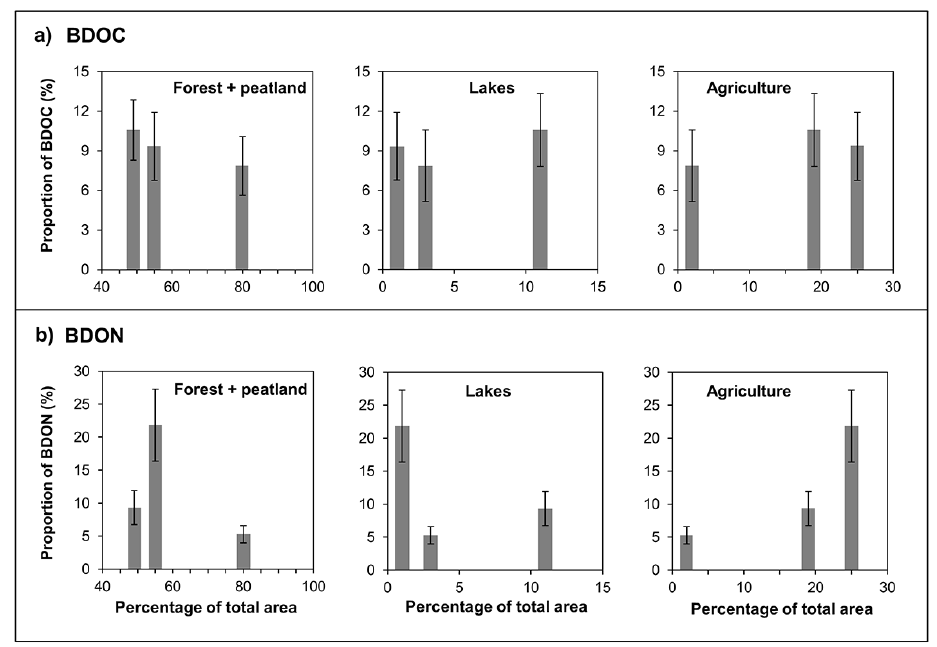
Fig. 3. Relationships between proportional land use categories and biodegradable fractions of DOC and DON of the whole pool (panels a and b , respectively). The proportion of different land use categories is presented as percentage of total catchment area on x axis and the biodegradable proportion of DOC and DON is on the y